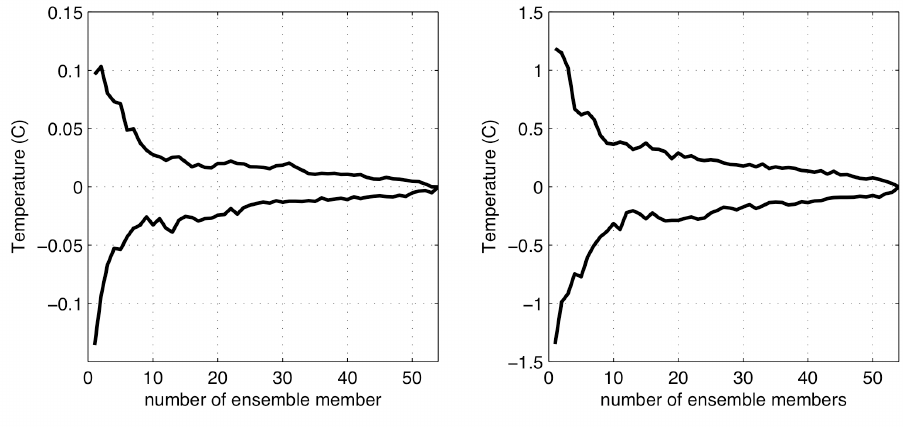
Fig. 3. The evolution of maximum and minimum Global-SST (left) and Nino-SST (right) deviation with the number of ensemble Figure 3. The evolution of maximum and minimum Global-SST (left) and Nino-SST 2 (right) deviation with the number of ensemble members. 3